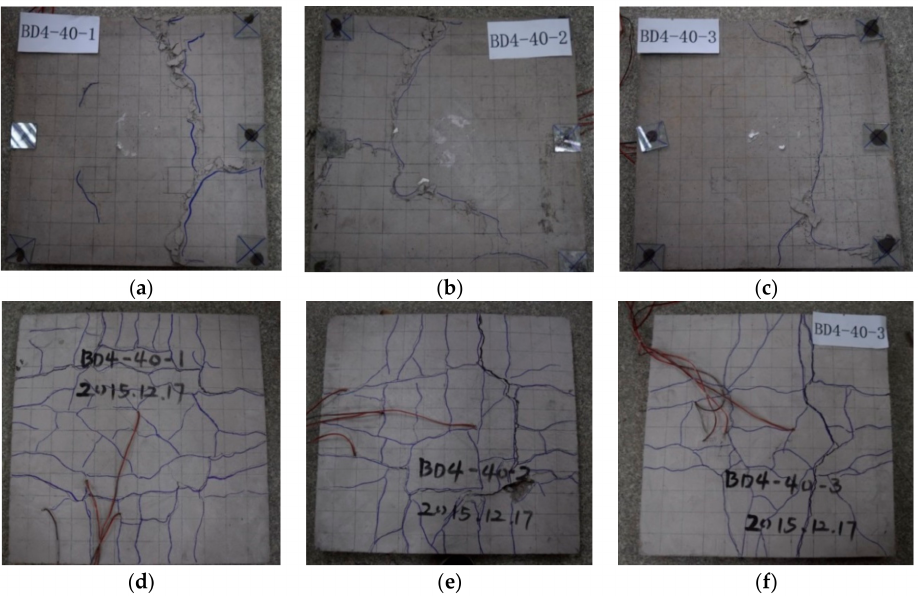
Figure 6. Failure modes of recycled concrete wallboard. ( a ) BD4-40-1 (top surface); ( b ) BD4-40-2 (top surface); ( c ) BD4-40-3 (top surface); ( d ) BD4-40-1 (bottom surface); ( e ) BD4-40-2 (bottom surface); ( f ) BD4-40-3 (bottom surface).